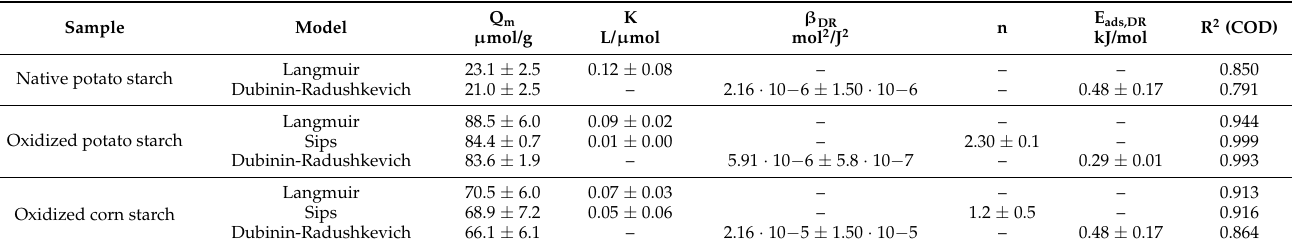
Table 4. Fitting parameters for Langmuir, Sips, and Dubinin-Radushkevich isotherm models for adsorption from Al 2 (SO 4 ) 3 solution. Here, Q m is the maximal sorption capacity, K is the equilibrium constant for the respective model, n is the Sips isotherm model exponent, and E ads,DR is the mean free energy of adsorption derived from the Dubinin-Radushkevich model. No applied model gave a reasonable fit to the isotherm of native corn starch. Sips isotherm model gave no reasonable fit for native potato